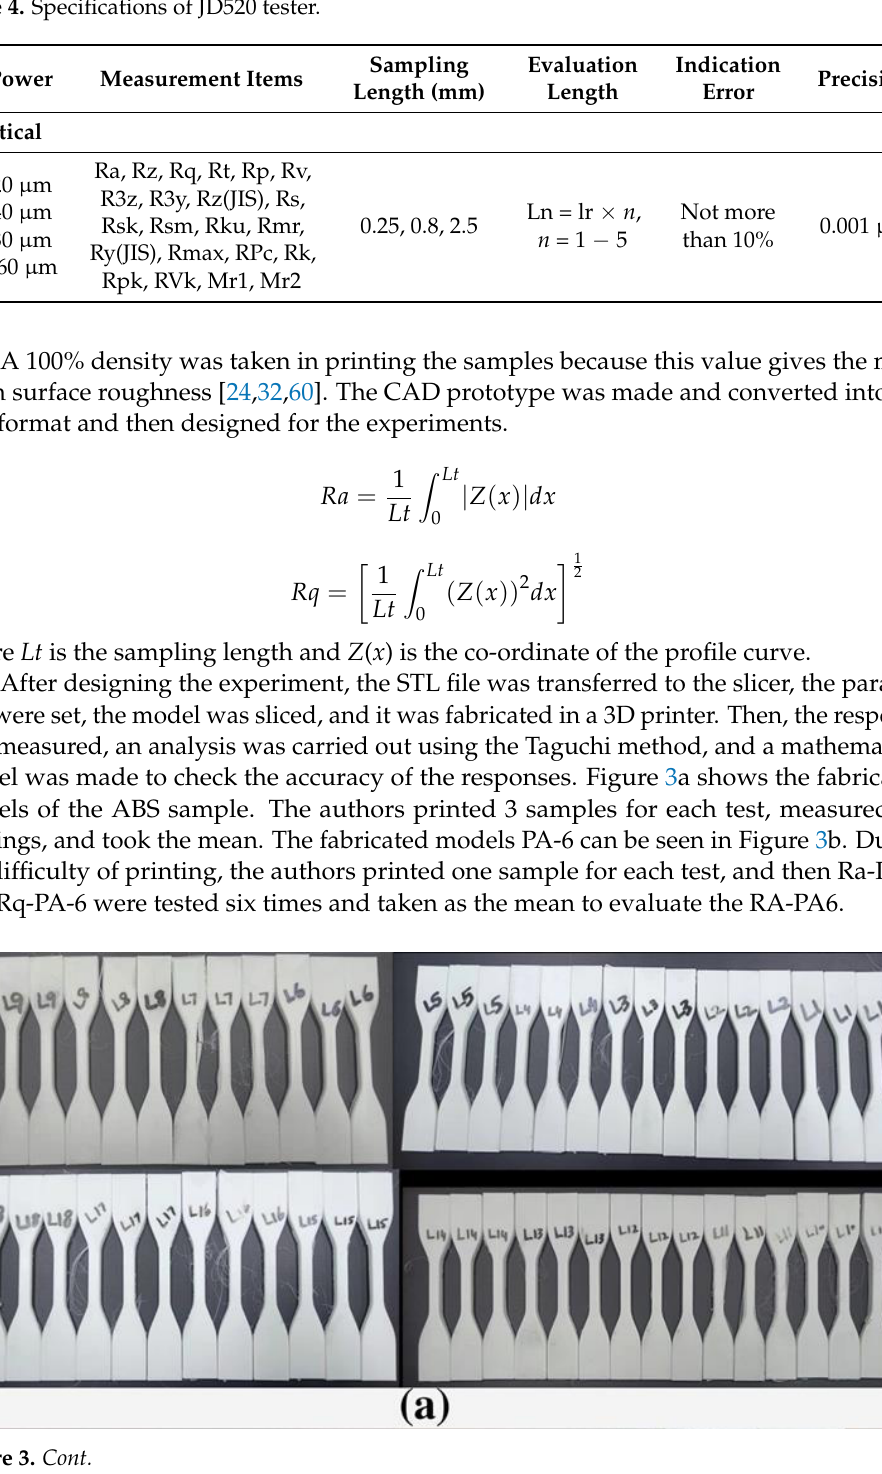
Figure 3. ( a ) FFF-Fabricated L18 experimental samples for ABS polymer. ( b ) FFF-Fabricated L9 ex- perimental samples for PA-6 polymer. 3. Results and Discussions 3.1. Taguchi Process Genichi Taguchi [61] employed this A loss function, which is the difference between the experimental and target values, which is then transformed into the S/N ratio. The S/N ratio is the ratio of the mean to the standard deviation. Dr. Taguchi adopted the term “signal” and “noise,” which refer to the desired response (mean) and unwanted (standard deviation) values. Taguchi classified the S/N ratio into three groups based on response requirements: higher-the-better, medium-the-better, and lower-the-better. In this investi- gation, the lower the quality parameters such as Ra and Rq, the better the surface quality. Equation (2) was used to compute the S/N ratio, with the findings displayed in Tables 5